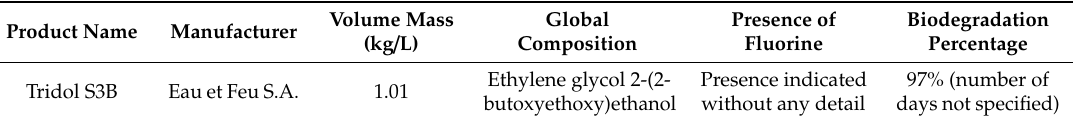
Table 1. General characteristics of a commercially-available fire-fighting foam according to its safety data